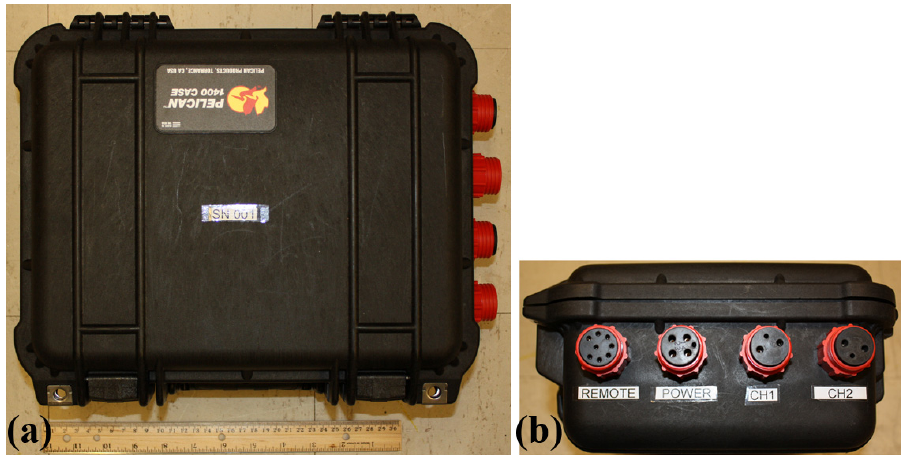
Figure 4. Non-submersible version of the Underwater Sound Recorder. ( a ) Pelican 1400 case; ( b ) external waterproof connections.